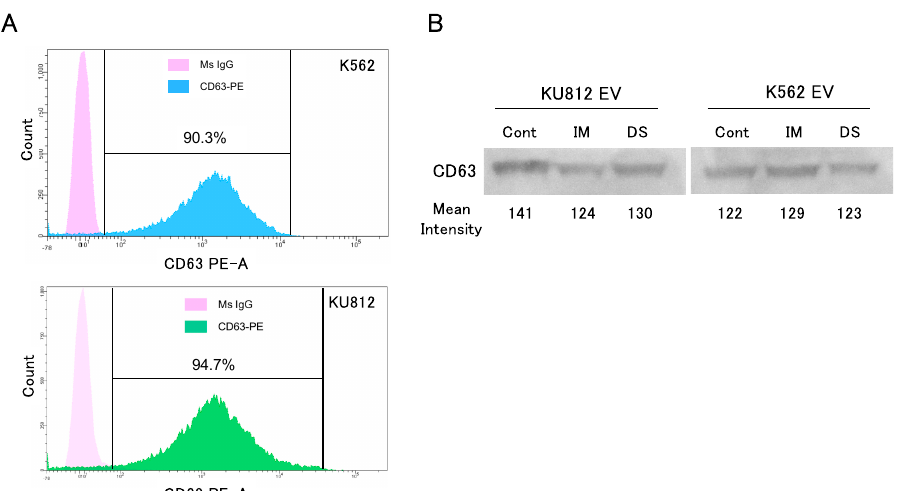
Figure 1. The purification and quantification of EV from the supernatant of cell cultures. ( A ) The purity of EVs was confirmed by surface CD63 antigen of EV by flowcytometric analysis. The upper histogram is the EVs from the K562 cell, and the lower histogram is EVs from KU812 cells. ( B ) EVs from each cell line were quantified by western blotting. The mean intensity of each band was measured by ImageJ software. (IM: imatinib, DS: dasatinib).